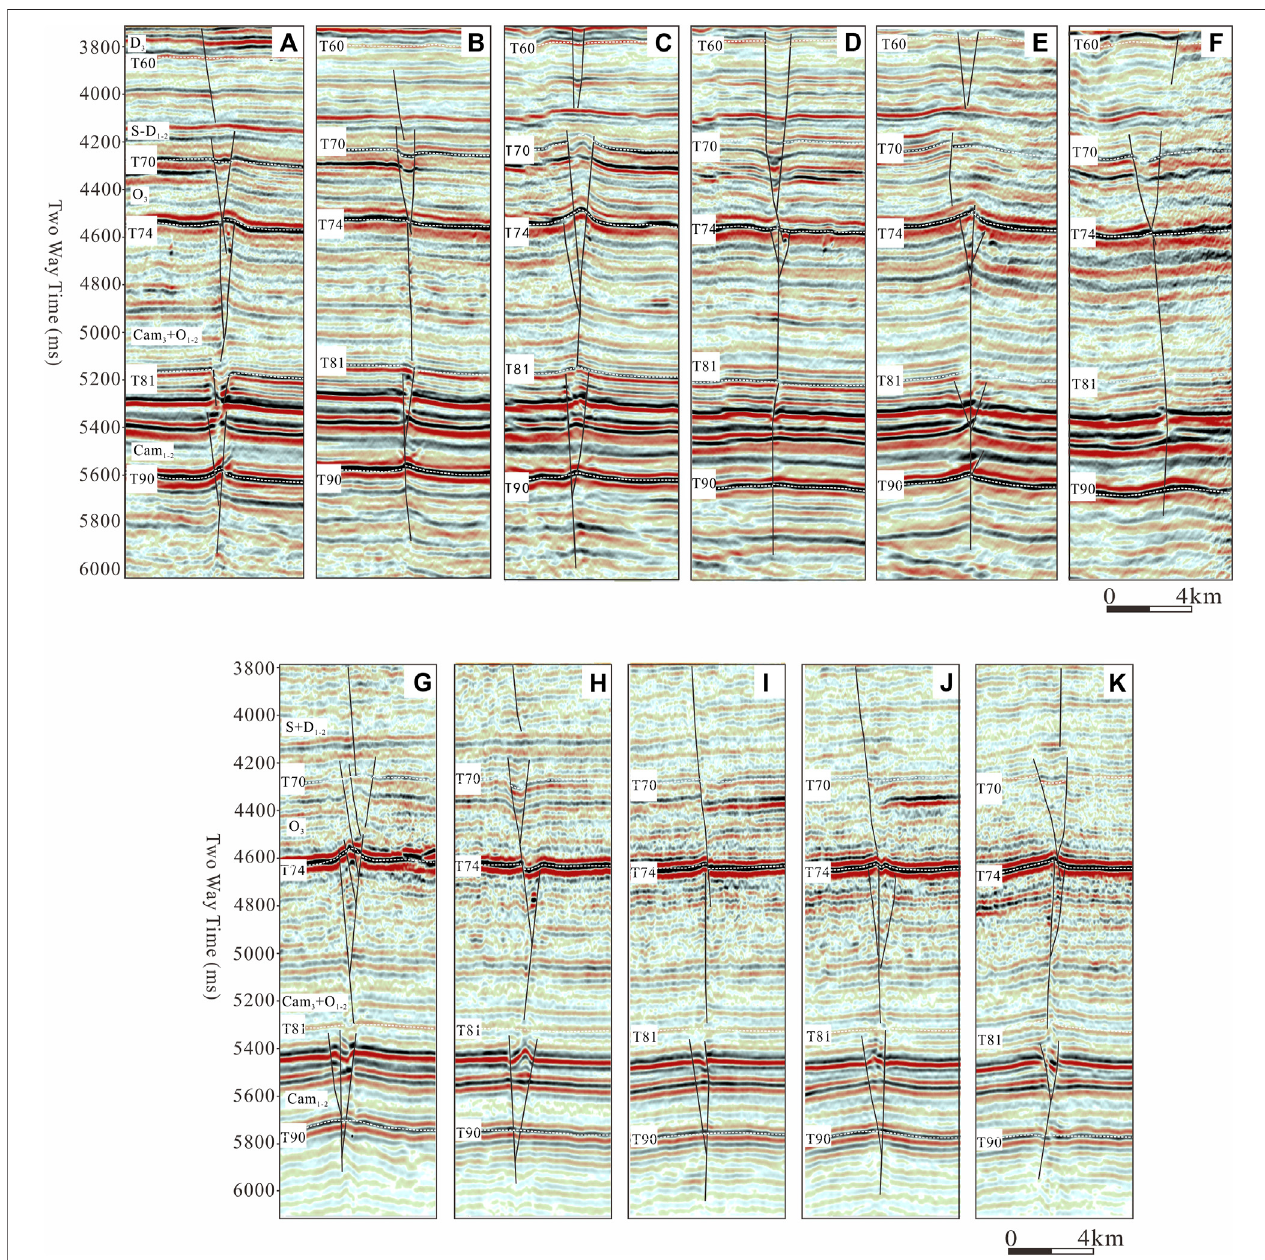
FIGURE 7 | 3D seismic pro fi les of the Shunbei 5 strike-slip deformation belt (SB5) (see Figure 6 for locations).